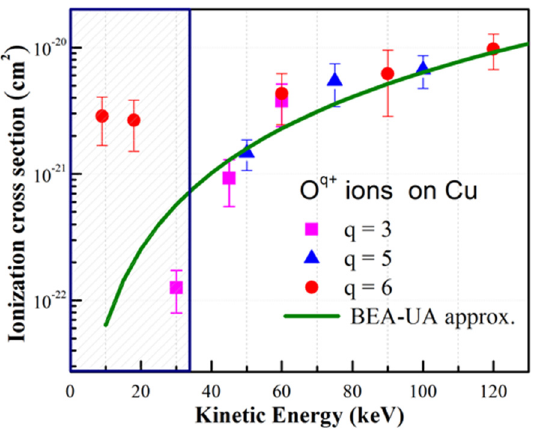
Figure 3. Measured K-shell ionization cross − sections for O q+ ions impinging on the Cu surface. The calculation of BEA with the united atom approximation is also shown.